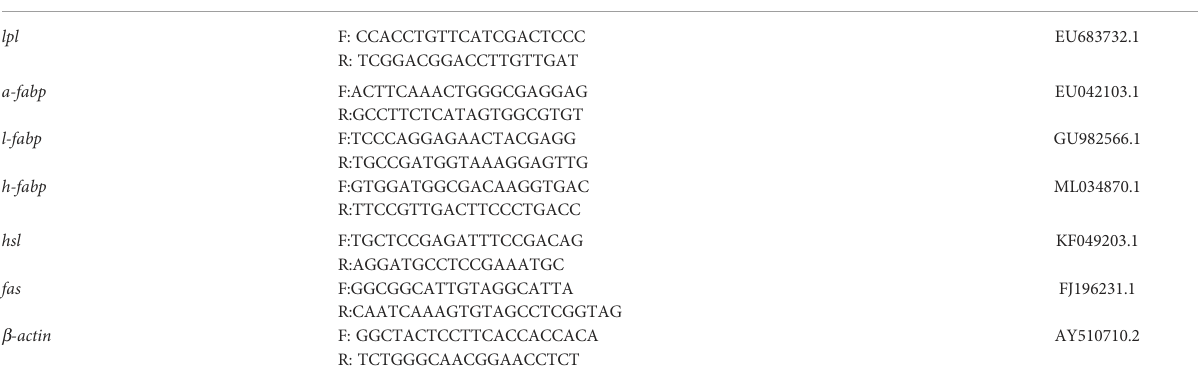
TABLE 2 Primers used